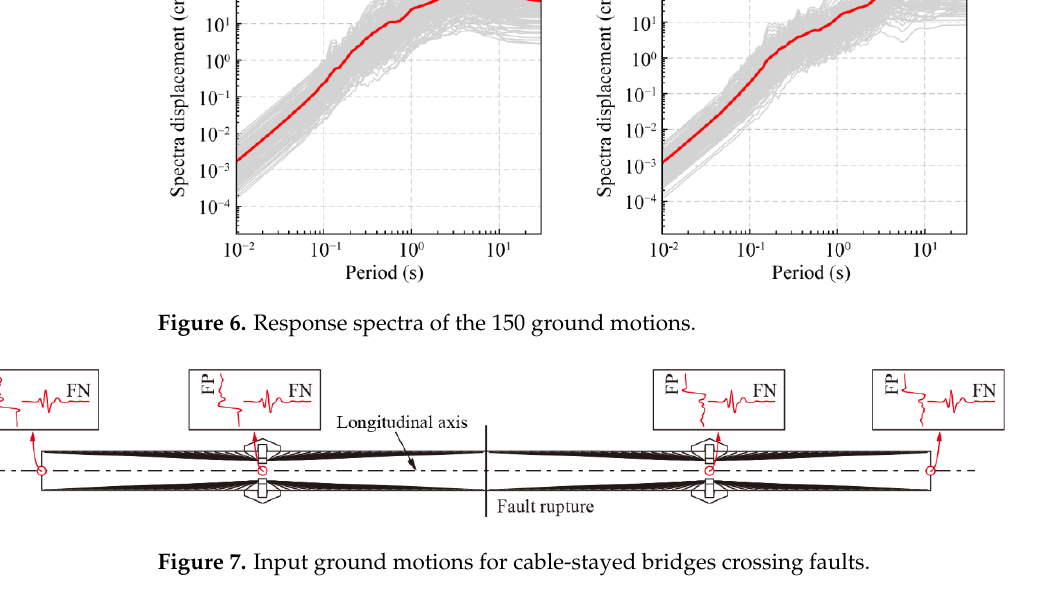
Figure 6. Response spectra of the 150 ground motions.